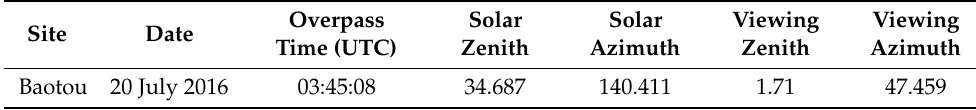
Table 4. Geometric conditions of ZY3-02 for radiometric